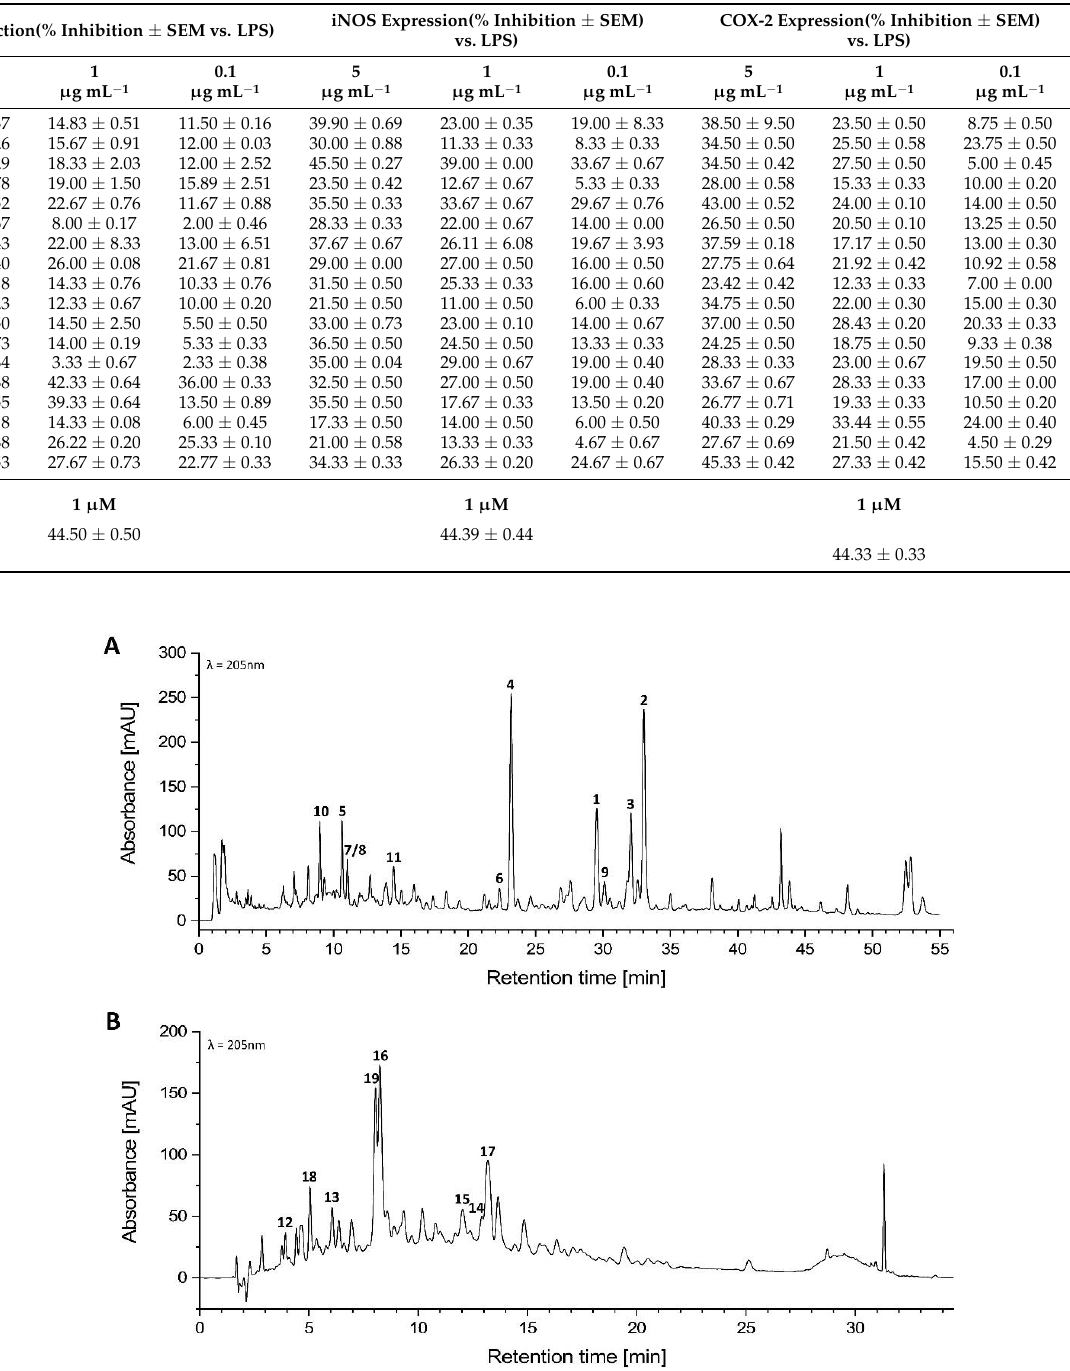
Table 1. NO production inhibition and iNOS and COX-2 expression inhibition vs. LPS ± SEM ( n = 3) for 18 subfractions from the DEE fraction of the methanolic extract of C. articulatus at 5, 1, and 0.1 µ g mL − 1 . Fractions indicated in bold were further investigated.